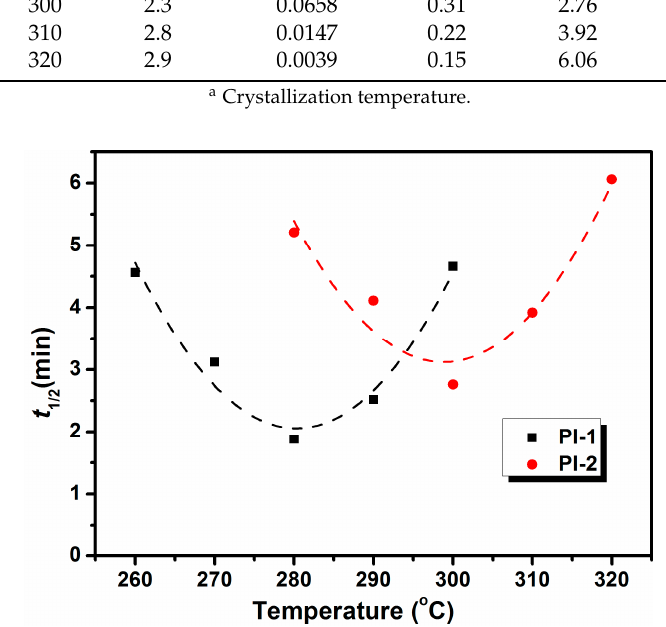
Figure 8. The crystallization half-time ( t 1/2 ) vs. crystallization temperature plot.